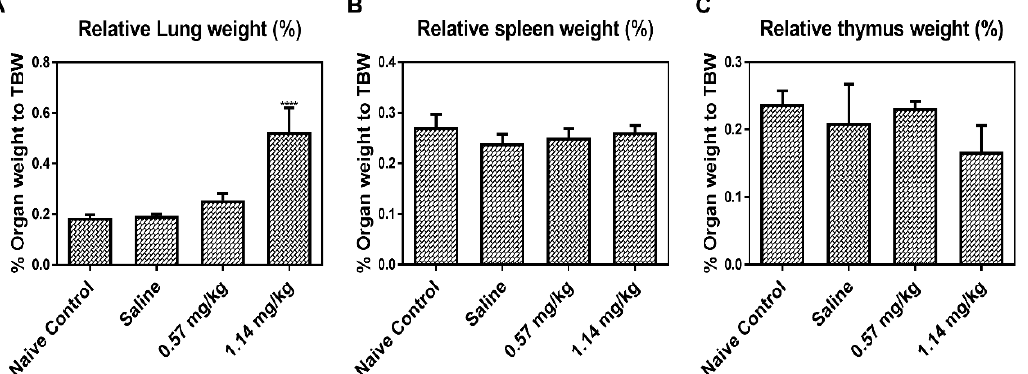
Figure 1. Changes in the relative lung, spleen, and thymus weights of normal control (NC), saline, and Kathon-exposed mice. Relative lung ( A ), spleen ( B ), and thymus ( C ) weights were calculated using the following formula: relative organ weight = organ weight (g) / terminal body weight (g) × 100%. Data are presented as the mean ± standard deviation ( n = 5 per group). **** p < 0.0001 vs. saline.